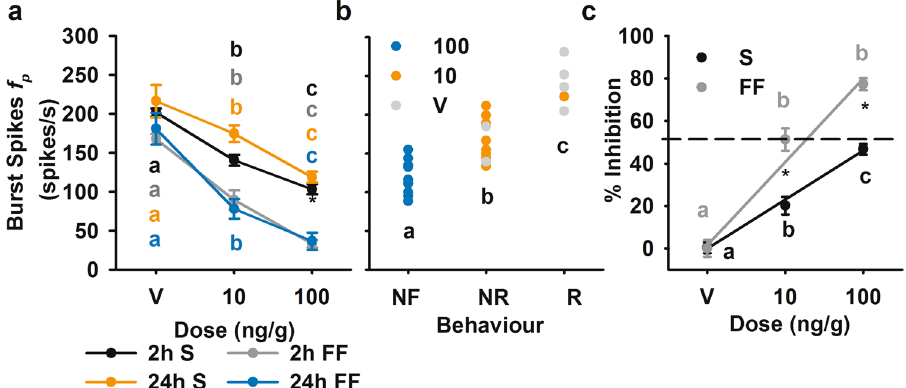
Figure 8. Effect of IMD on burst spike peak firing rate ( f p ) and correlation with observed behavioural deficits. ( a ) Burst spike peak f p at 2 and 24 hours after treatment, for stimuli presented against simple (S) and flow field (FF) backgrounds. ( b ) Burst spike f p correlated with flight behaviour at 24 hours after treatment with IMD or vehicle: NF, not flying; NR, flying but not responding; R, responding with a turn or glide, with a Pearson correlation coefficient of 0.872. Each data point represents measurements from a single animal, and letters denote significant differences between means. ( c ) Percent inhibition with effects at 2 and 24 hours combined for each background type, plotted as percent reduction from the mean of the vehicle treatment group. Colour coded letters denote significant differences between treatments within each background, and asterisks denote significant differences between S and FF within